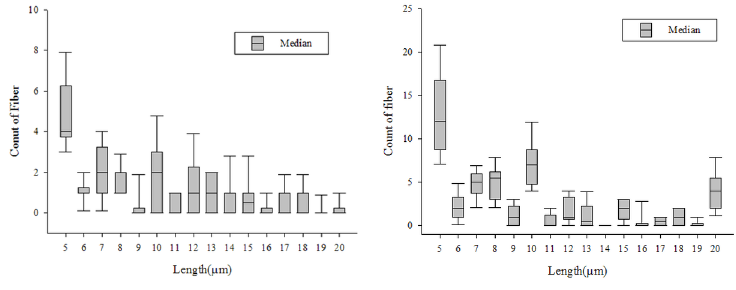
Fig 7. Length distribution of asbestos type generated(serpentine, amphibole type).